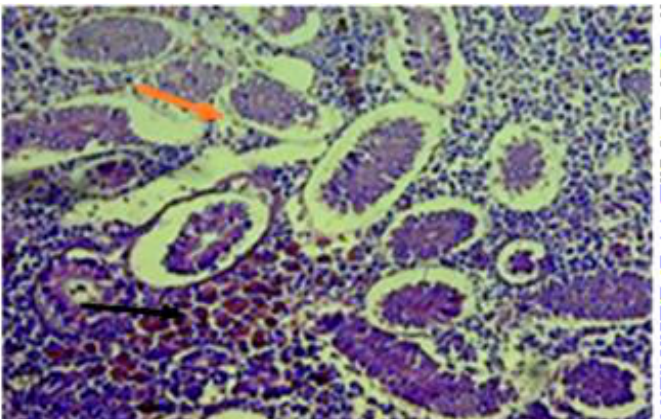
Figure 3. Histopathological section of kidney shows depletion of hemopoietic tissue ( ) with increase in melanomacrophage deposition (